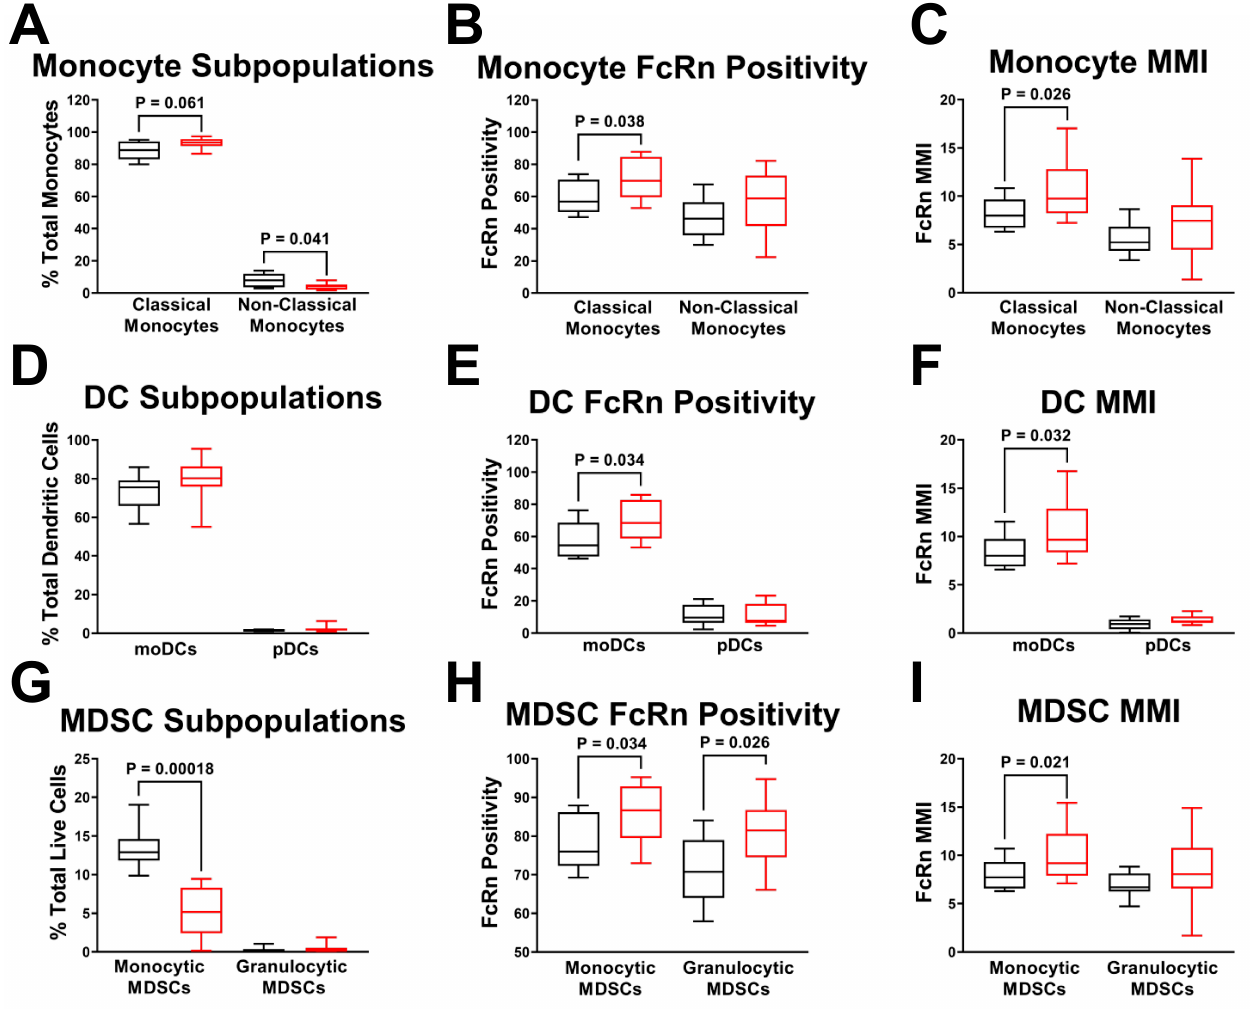
Figure 6. Myeloid Cell Subpopulations have Differential Expression of FcRn. Subpopulations of monocytes, dendritic cells and MDSCs ( A ) Monocytes subdivided into classical and non-classical status with quantification of ( B ) monocyte FcRn positivity and ( C ) monocyte FcRn MMI ( D ) Dendritic cells subdivided into monocytic dendritic cells and plasmacytoid dendritic cells with quantification of ( E ) DC FcRn positivity and ( F ) DC FcRn MMI. ( G ) MDSCs were subdivided into monocytic and granulocytic MDSC populations with quantification of ( H ) MDSCs FcRn positivity and ( I ) MDSC FcRn MMI. Non-cancer patient (black, n = 8) and PDAC patient (red, n = 13). Box and whisker plots represent the median and interquartile range (25–75%) with whiskers representing the outlying 25%. All statistics are done with unpaired t -tests with a Welch’s correction.